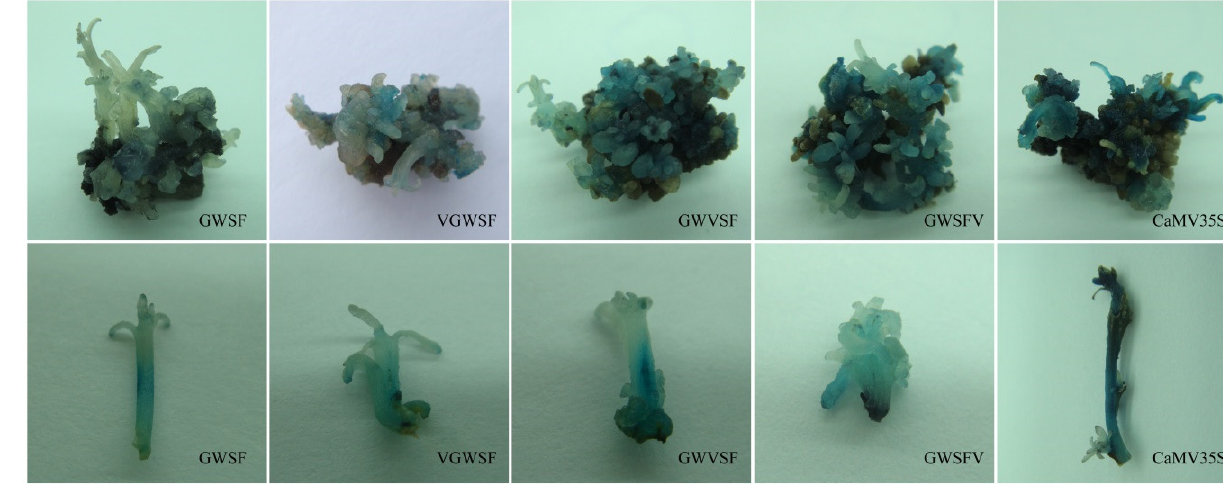
Figure 2. GUS histochemical staining for evaluation of the basal transcription activities of improved promoters in transgenic calli and adventitious buds of E. urophylla . GWSF was the original promoter. V-element dimers were inserted into the upstream (VGWSF), midstream (GWVSF), or downstream (GWSFV) of the original promoter (GWSF) to obtain three modified promoters, respectively. Results of transgenic calli (in the upper row) and adventitious buds (in the lower row) are showed.